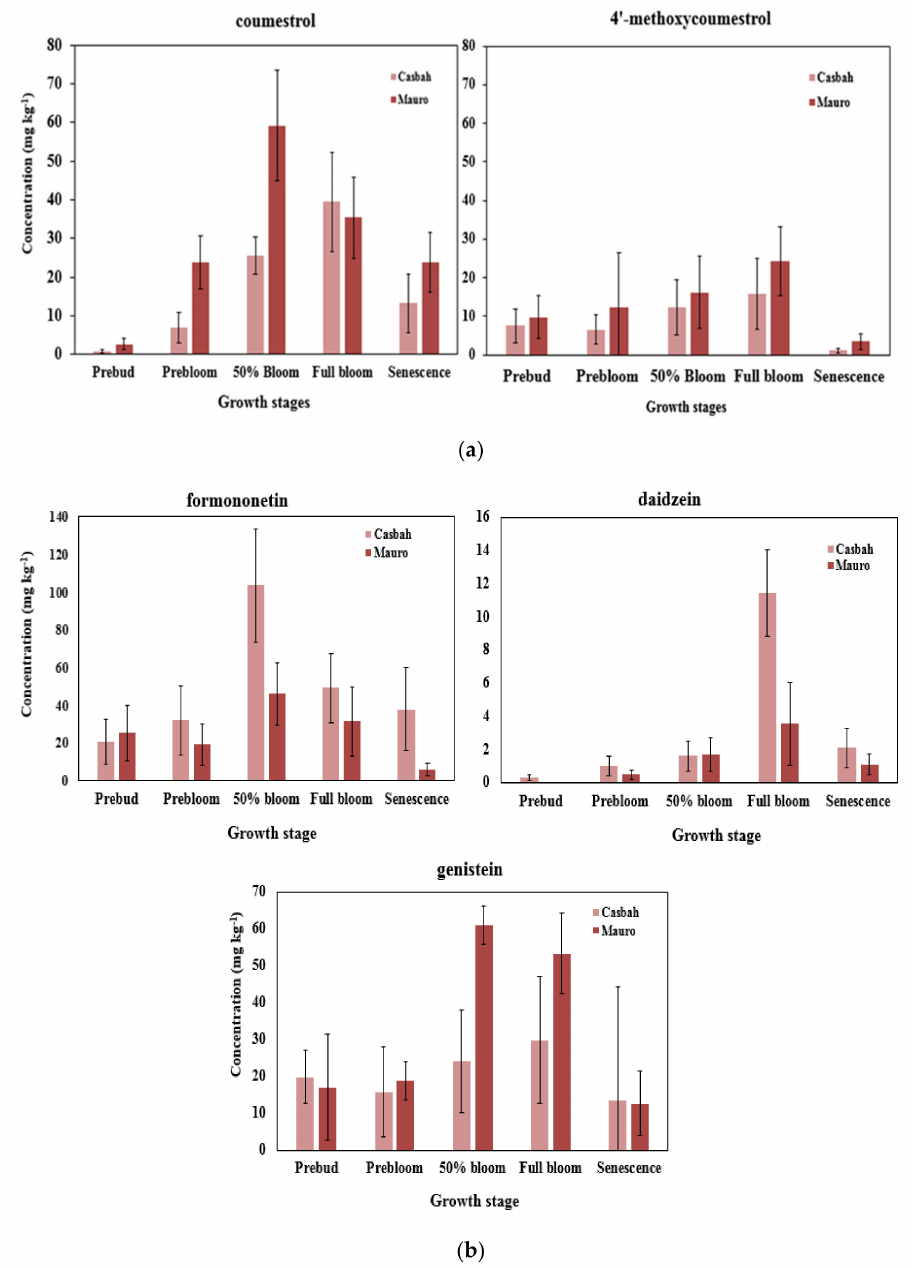
Figure 2. ( a ) The concentration of coumestrol and 4 (cid:48) -methoxycoumestrol at five growth stages i.e., pre bud, pre bloom, 50% bloom, full bloom, and senescence of field-grown biserrula cv. Casbah and cv. Mauro averaged over two years. Error bars indicate standard deviation; ( b ) the concentration of selected isoflavones at five growth stages i.e., pre bud, pre bloom, 50% bloom, full bloom, and senescence in biserrula cv. Casbah and cv. Mauro samples averaged over two years. Error bars indicate standard